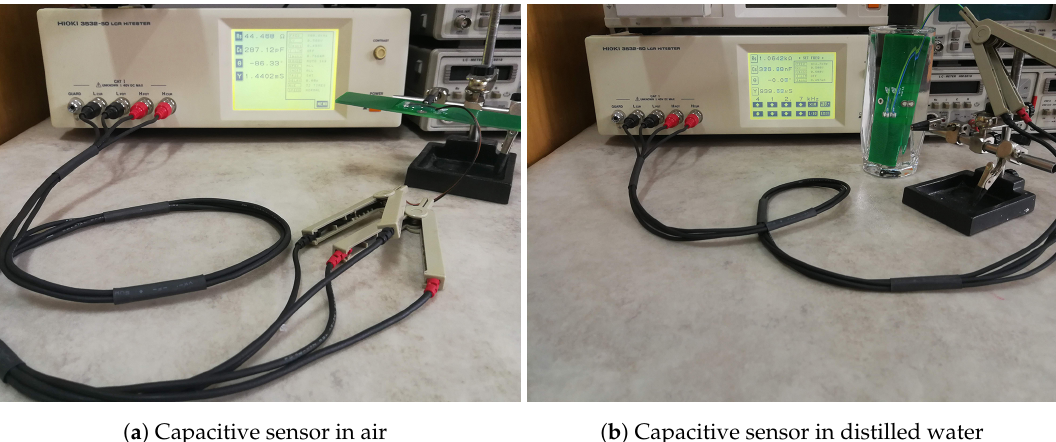
Figure 8. Measurement setup for capacitive sensors with a HIOKI 3532-50 LCR Meter. The DUT is connected via a quadripolar connection with a small wire